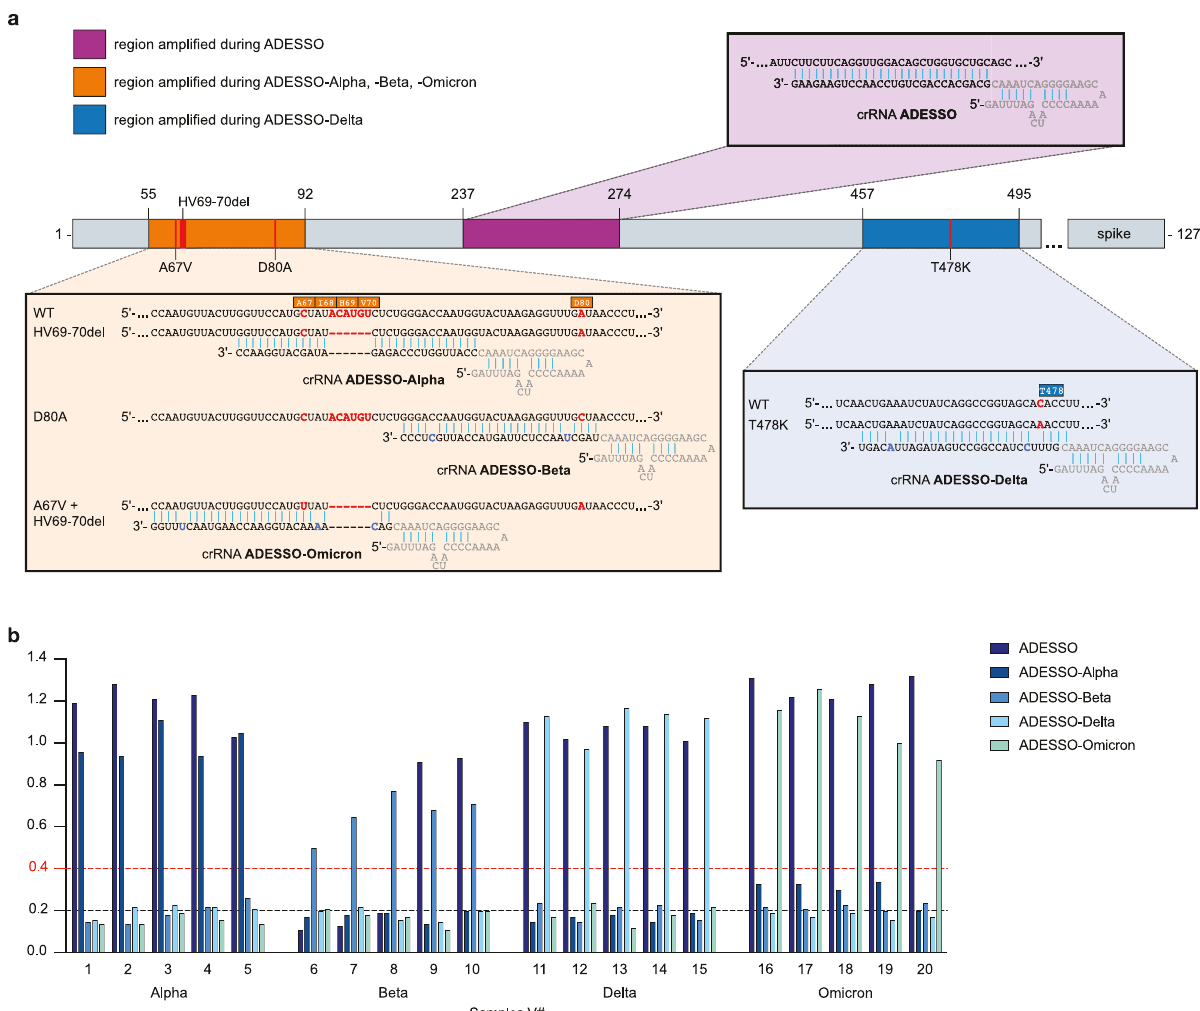
Fig. 3 Adaptation of ADESSO for detection of SARS-CoV-2 variants. a Schematic of SARS-CoV-2 S gene with annotation of the regions ampli fi ed during the different ADESSO tests (highlighted in different colors). The speci fi c regions (and mutations) recognized by the different crRNAs are also shown for each test. Genomic sites that are mutated in at least one SARS-CoV-2 variant are highlighted in red. The synthetic mismatches introduced within the crRNAs are highlighted in blue. b SARS-CoV-2 variant detection by ADESSO, ADESSO-Alpha, ADESSO-Beta, ADESSO-Delta and ADESSO-Omicron in 20 clinical samples. Dashed lines represent the threshold to distinguish between positive and negative samples in ADESSO (black line) and ADESSO-variant (red